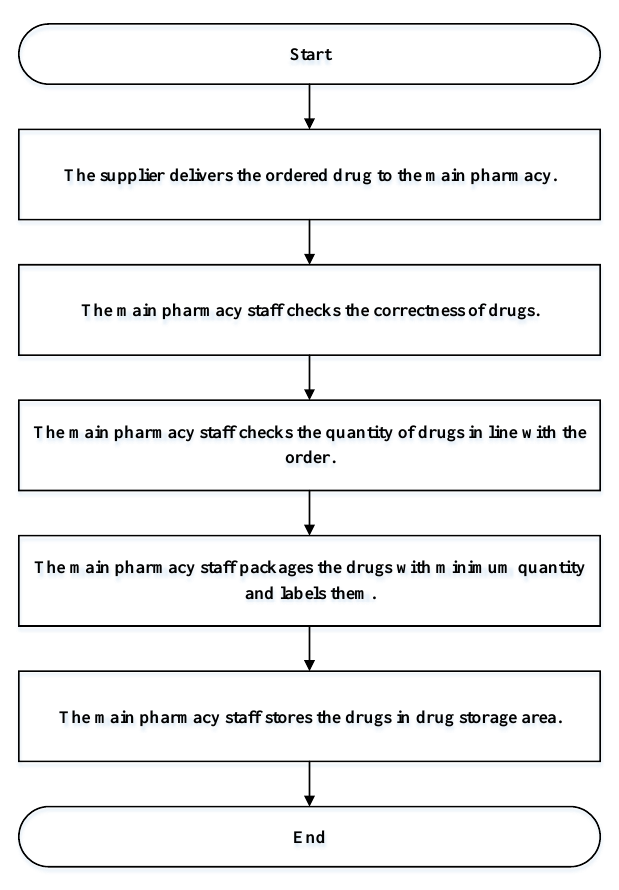
Figure 4. The replenishment process of the main pharmacy.